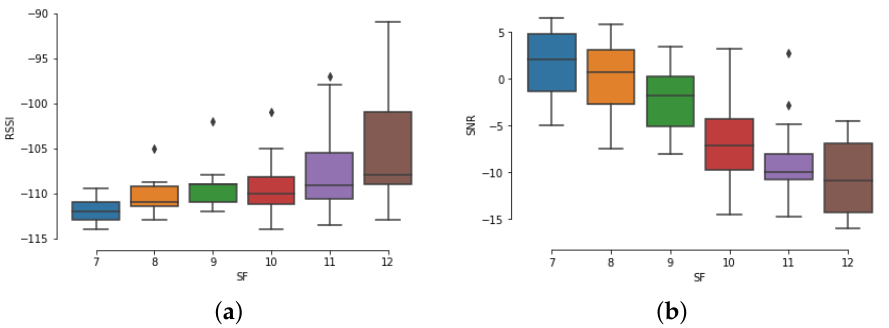
Figure 27. Average RSSI and SNR per SF LoRaWAN. ( a ) RSSI. ( b )